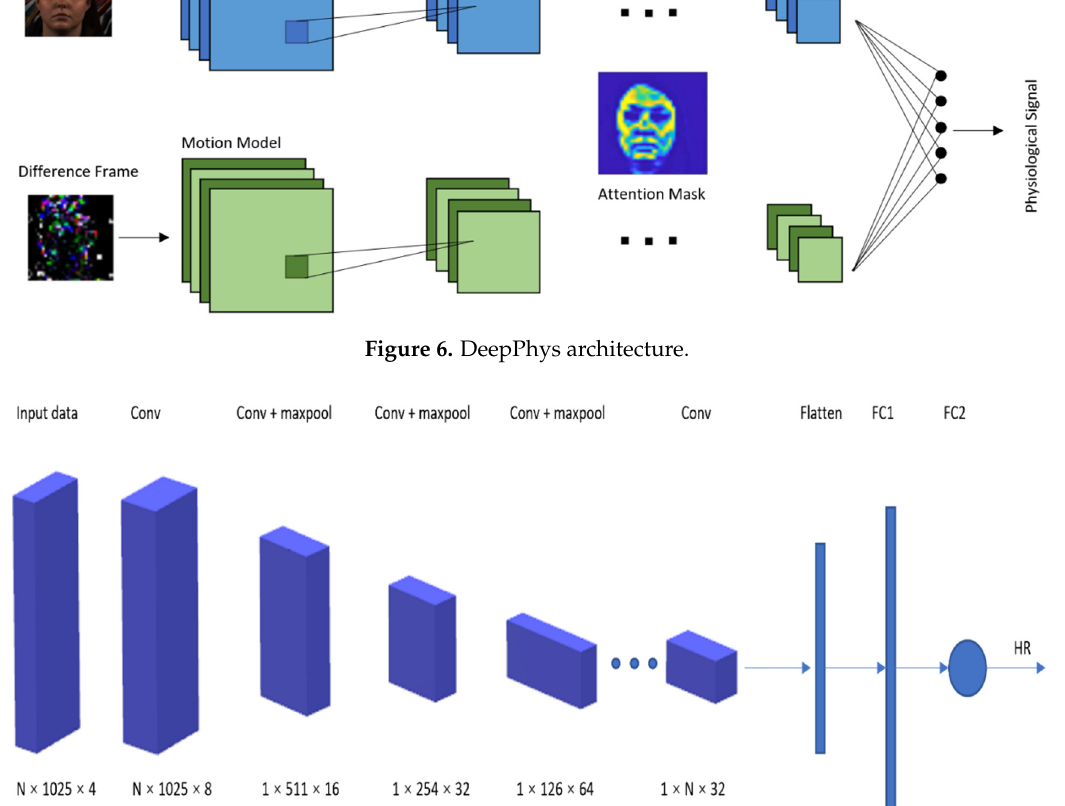
Figure 7. Deep PPG architecture. Figure 7. Deep PPG